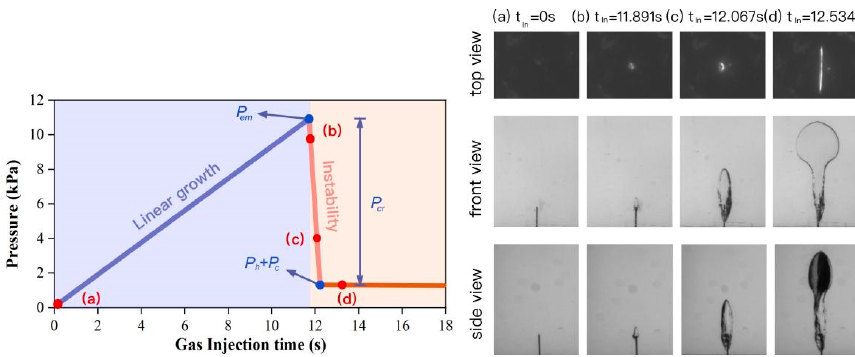
Figure 5. Pressure curve of the gas injection test and corresponding bubble shapes.